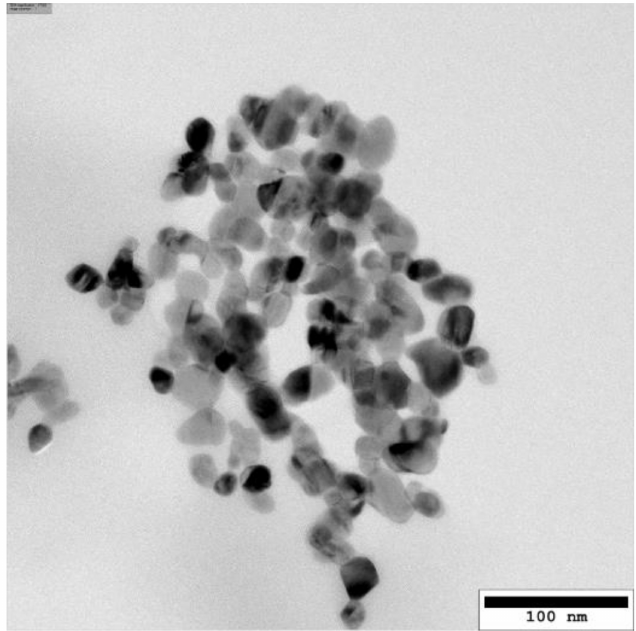
Figure 1. Representative TEM image of the CuO NP at 2.56 mg/mL in 0.05% bovine serum albumin (BSA) after dispersion. More images are shown in Supplementary Figure